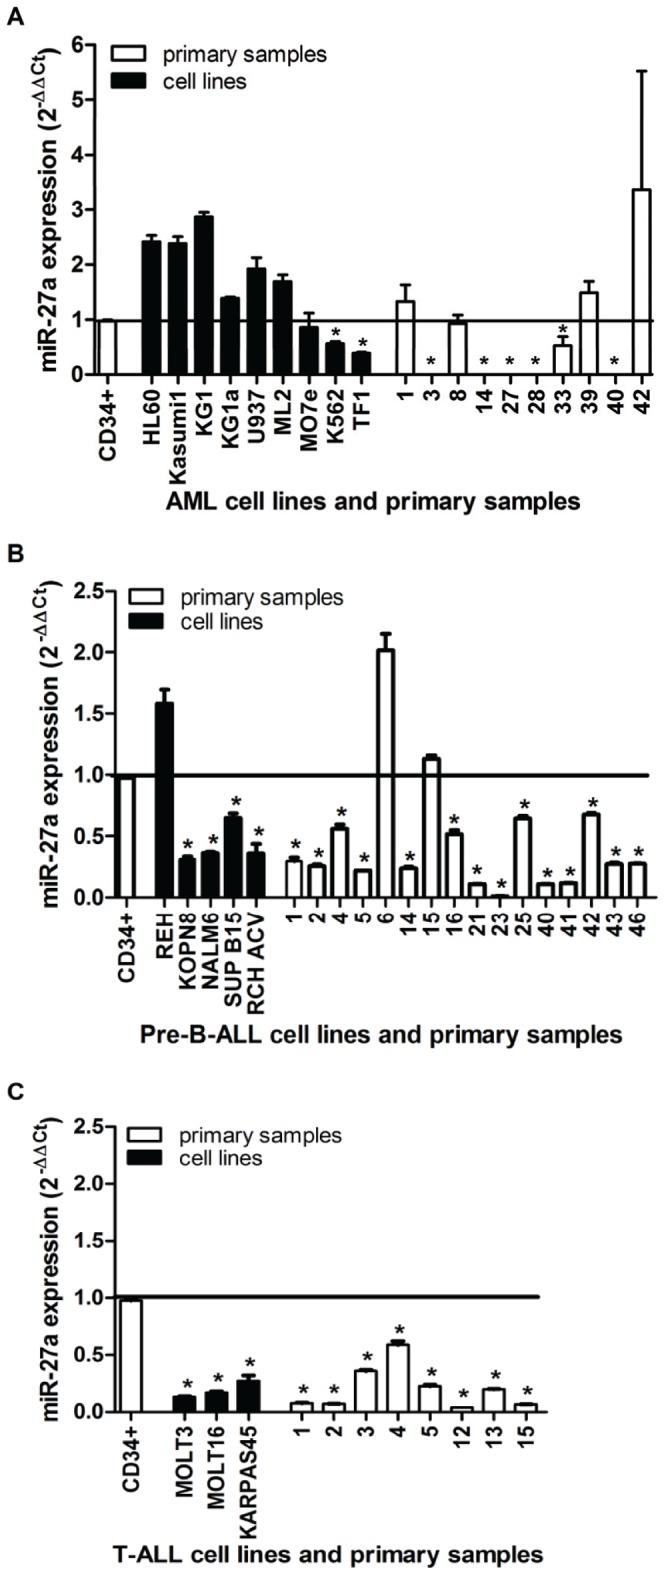
Expression levels of mature miR-27a in AML, pre-B-ALL, and T-ALL cell lines and primary samples.Total RNA was isolated from human AML (A), pre-B-ALL (B), and T-ALL (C) cell lines (black bars) and primary cases (primary patient cases identified with unique numbers, white bars). MiR-27a expression levels were normalized to mean levels in normal human CD34+ HSPCs (2−ΔΔCt = 0.9756±0.022, black line). A Student's t-test was used to determine the significance of the difference in mean miR-27a expression (±SEM) between each leukemia samples and normal CD34+ HSPCs; significance is indicated as p<0.05 (*). n≥3 independent experiments in all cases except for the 10 primary AMLs which were analyzed in triplicate due to limited sample quantity.